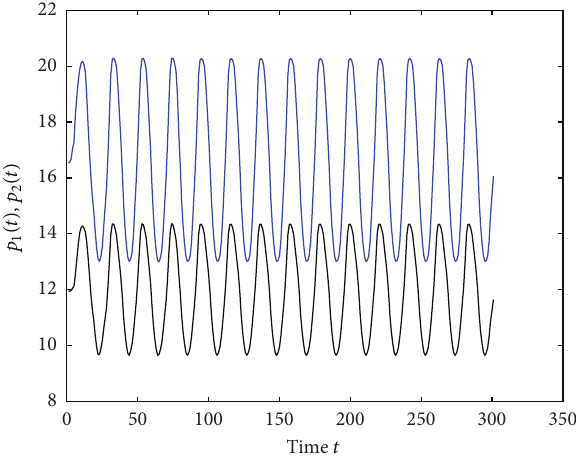
Figure 1: (𝑡,𝑝 1 (𝑡)) and (𝑡,𝑝 2 (𝑡)) , for 𝜏 < 𝜏 0 .